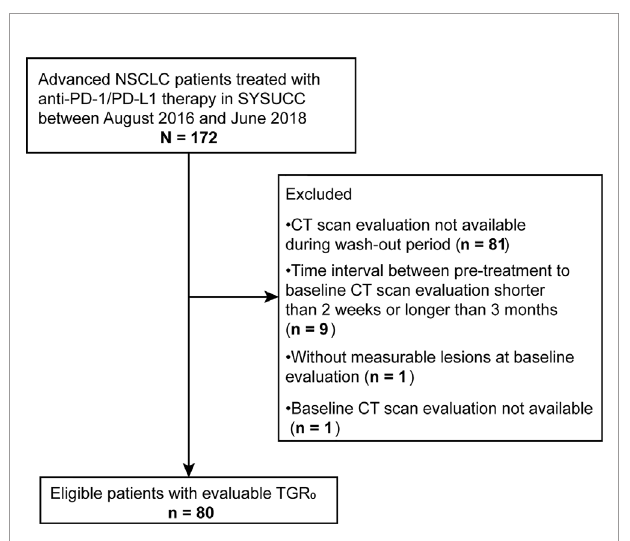
FIGURE 2 | Flowchart of patient screening process.